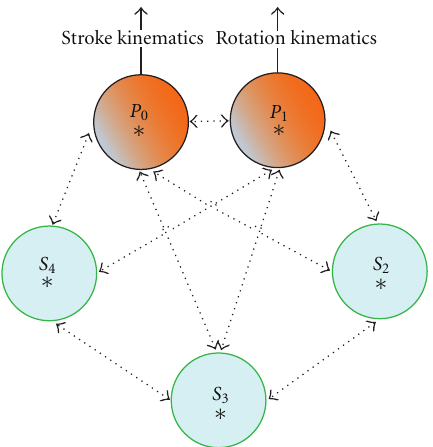
Figure 15: The above figure shows the neuron output state dynamics of each neuron in the reduced five-neuron architecture of the cruise controller architecture shown in Figure 12. It can be noticed that qualitatively the output dynamics of each neuron do not di ff er significantly from their original behavior shown in Figure